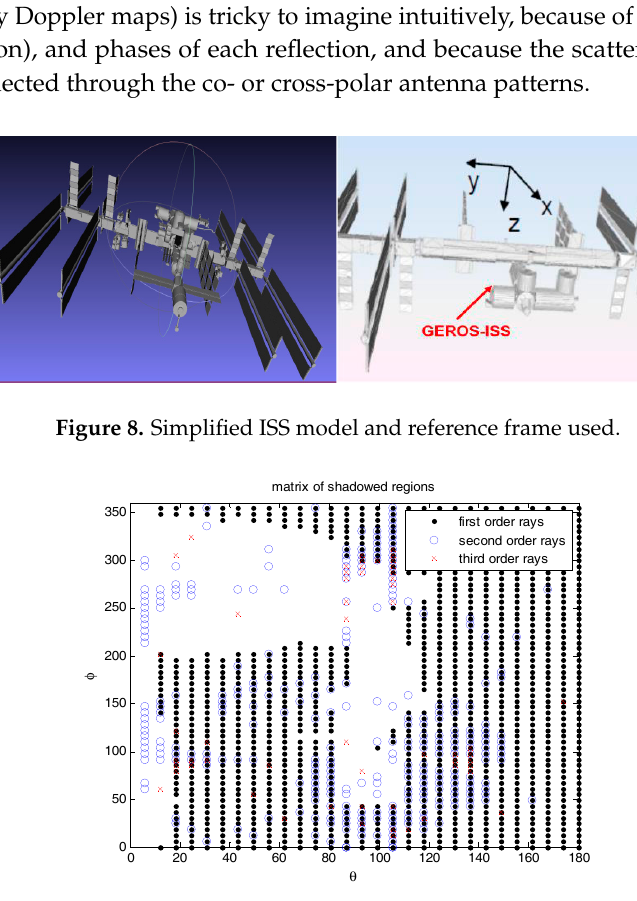
Figure 9. Graphical representation of the directions of arrival of direct signal or first order rays (no reflections) ( · ), second order rays (one reflection) ( o ), and third order rays (two-reflections) ( x ). Empty areas correspond to shadowed directions blocked by the ISS structure.